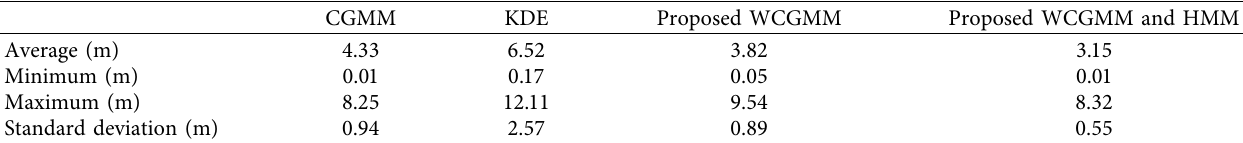
Table 3: Comparative analysis of the position accuracy of lane